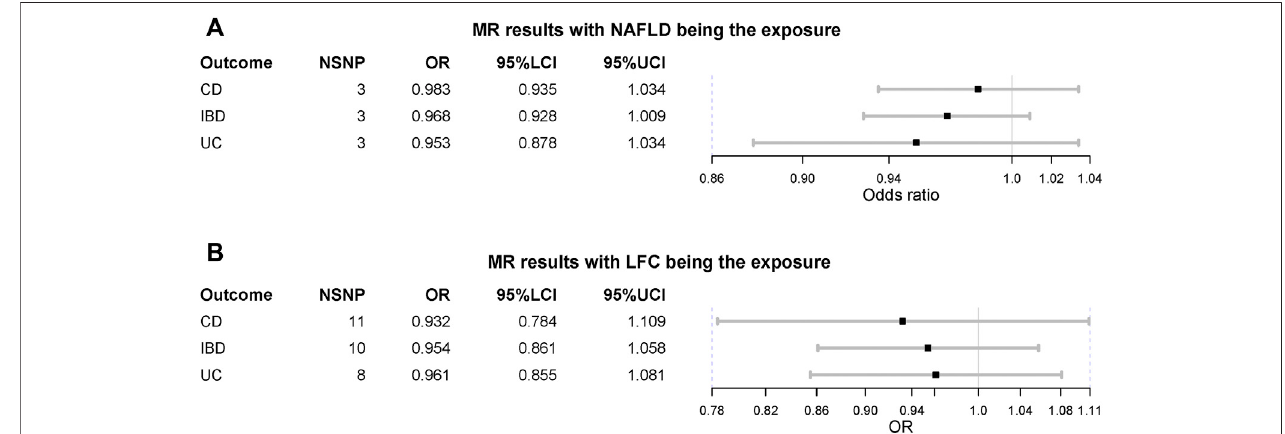
FIGURE 3 | Mendelian randomization (MR) results where non-alcoholic fatty liver disease and liver fat content as the exposures. NAFLD is non-alcoholic fatty liver disease; LFC is liver fat content; CD is Crohn ’ s disease; IBD is in fl ammatory bowel disease; UC is ulcerative colitis; NSNP is the number of single nucleotide polymorphismsusedinMRanalysis;ORisoddsratio;95%LCIisthelowerlimitof95%con fi denceintervalofOR;95%UCIistheupperlimitof95%con fi denceintervalof OR; P is the p -value of OR.